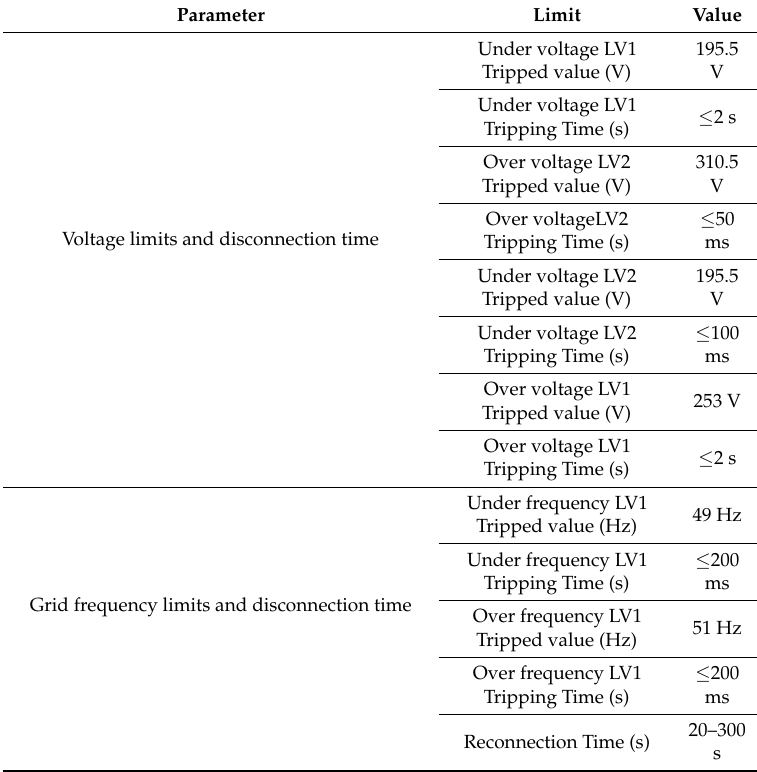
Table 5. Power sharing between DES, grid and loads during Off